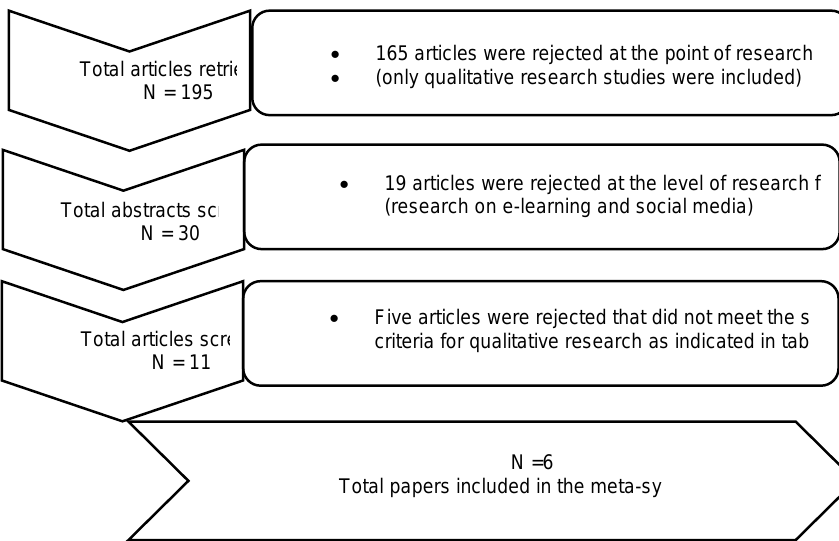
Figure 3 . Summary of research study screening and selection